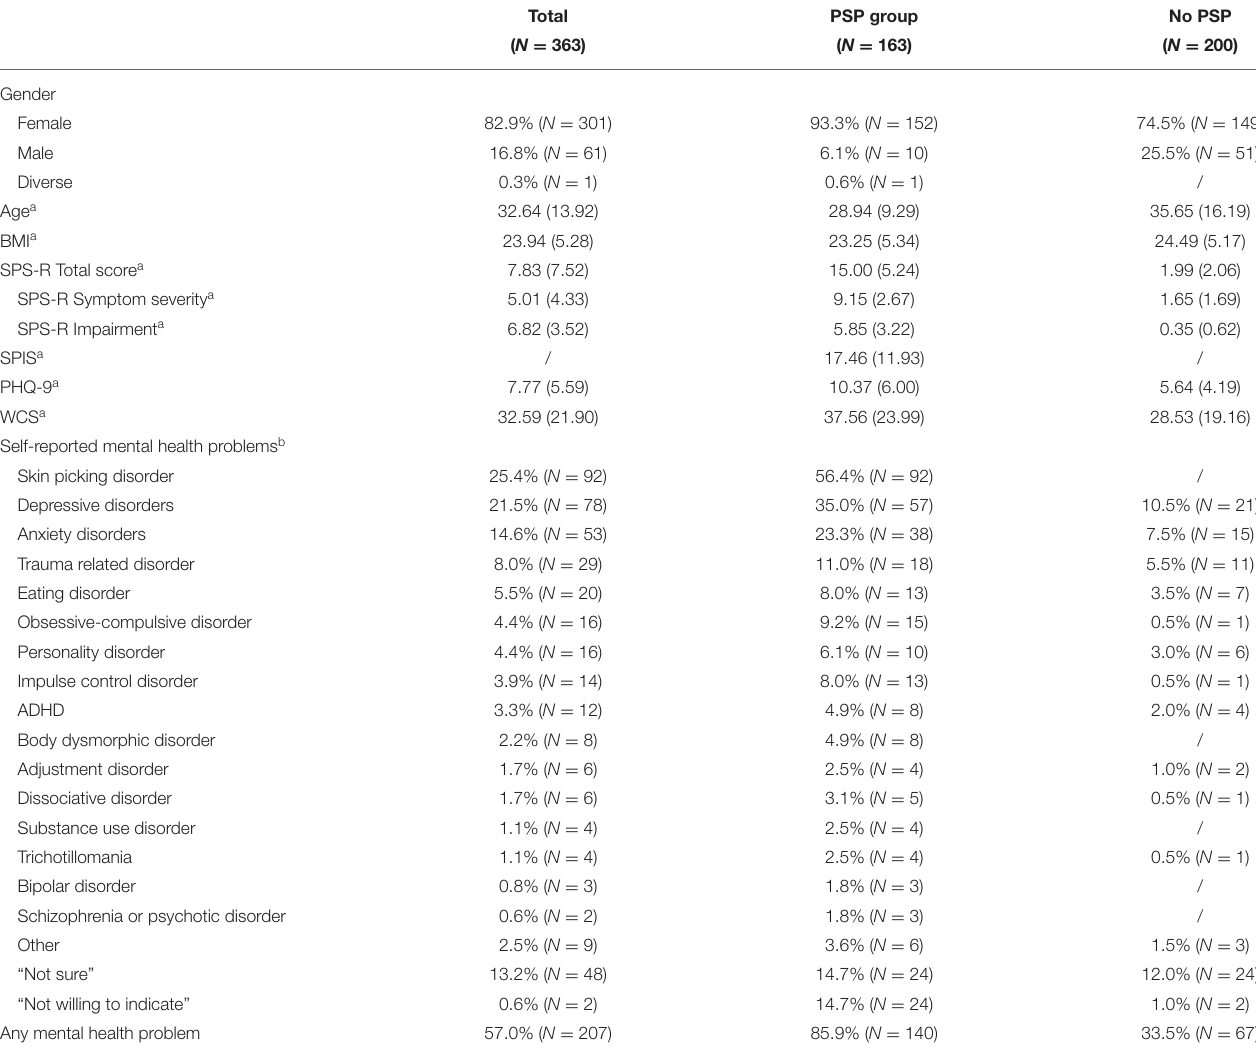
TABLE 1 | Demographic characteristics and clinical